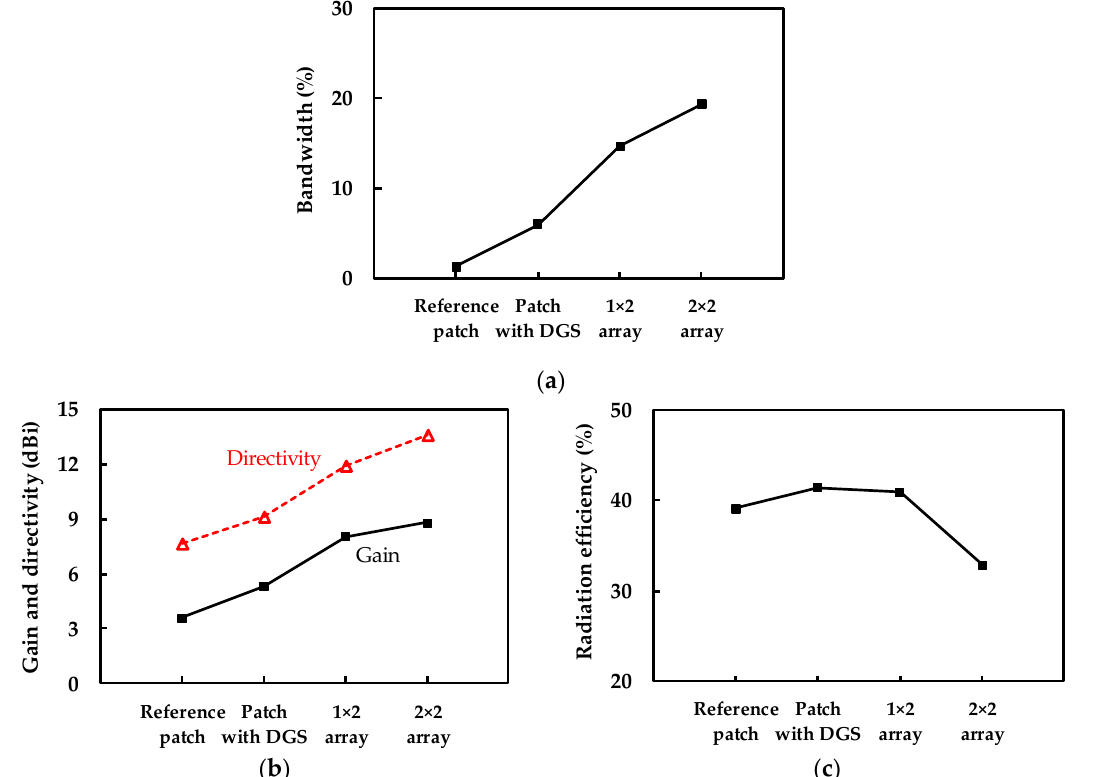
Figure 8. Comparison of simulated performance of designed antenna. ( a ) Bandwidth for reflection coefficient less than − 10 dB. ( b ) Gain and directivity. ( c ) Radiation efficiency.